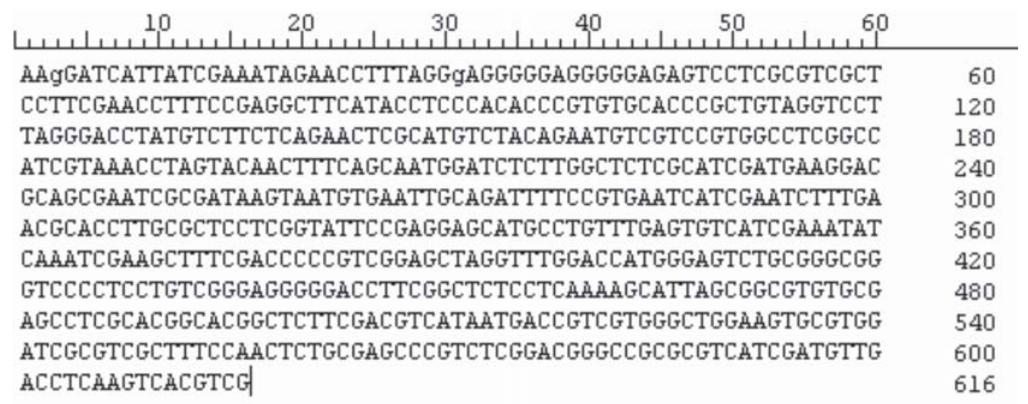
Figura 3 . Seqüência molecular do isolado Scleroderma UFSMSc1, da região do ITS (Internal Transcript Spacer).